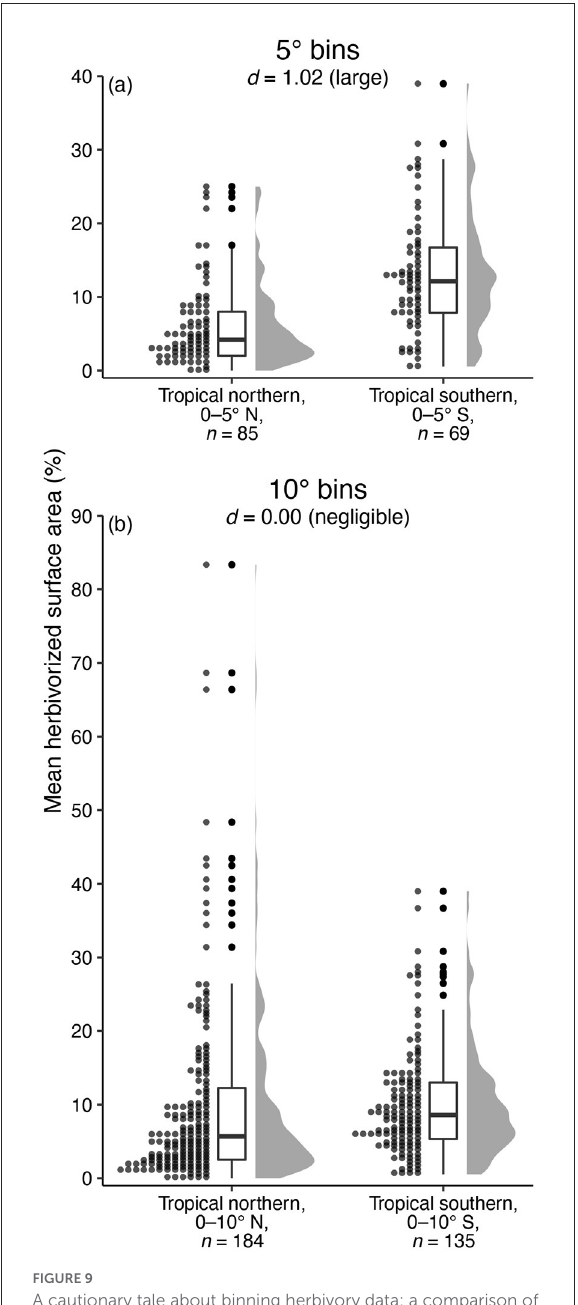
FIGURE9 A cautionary tale about binning herbivory data: a comparison of the amount of leaf area lost to insect herbivory at tropical northern and tropical southern latitudes in modern ecosystems, from the compilation of Zhang et al. (2016). The perceived difference in herbivory at tropical northern vs. tropical southern latitudes depends greatly on whether bins extend five (a) or ten (b) degrees from the